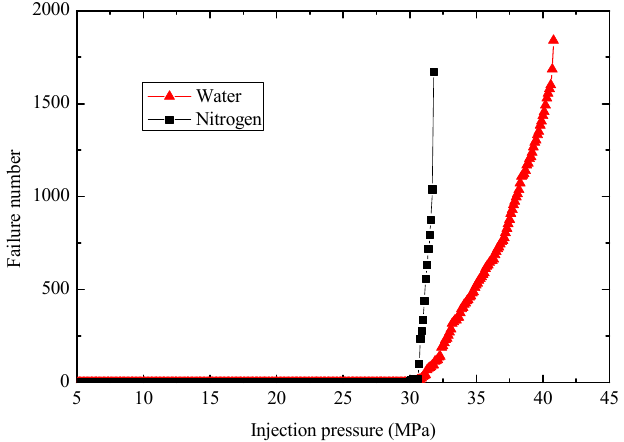
Figure 12. Failure number during water fracturing and nitrogen fracturing.